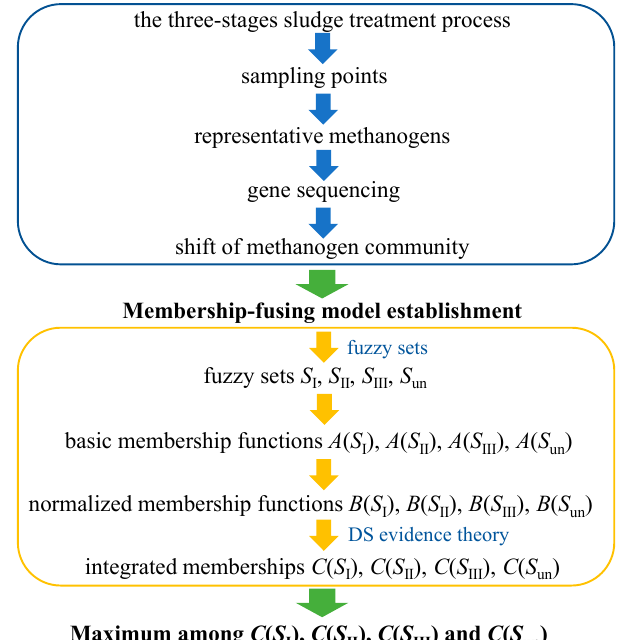
Figure 1. Procedure to build the membership-fusing model. 138